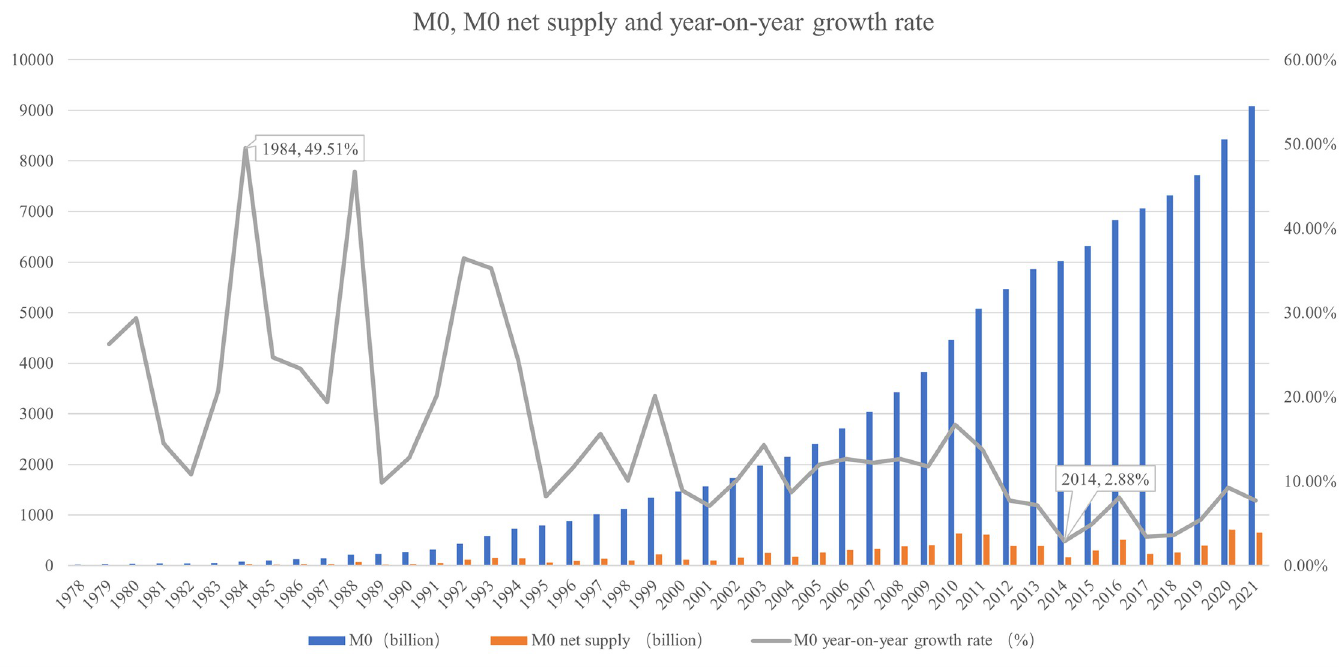
Fig 2. Net supply and year on year growth of M0 and M0. Source: People’s Bank of China.